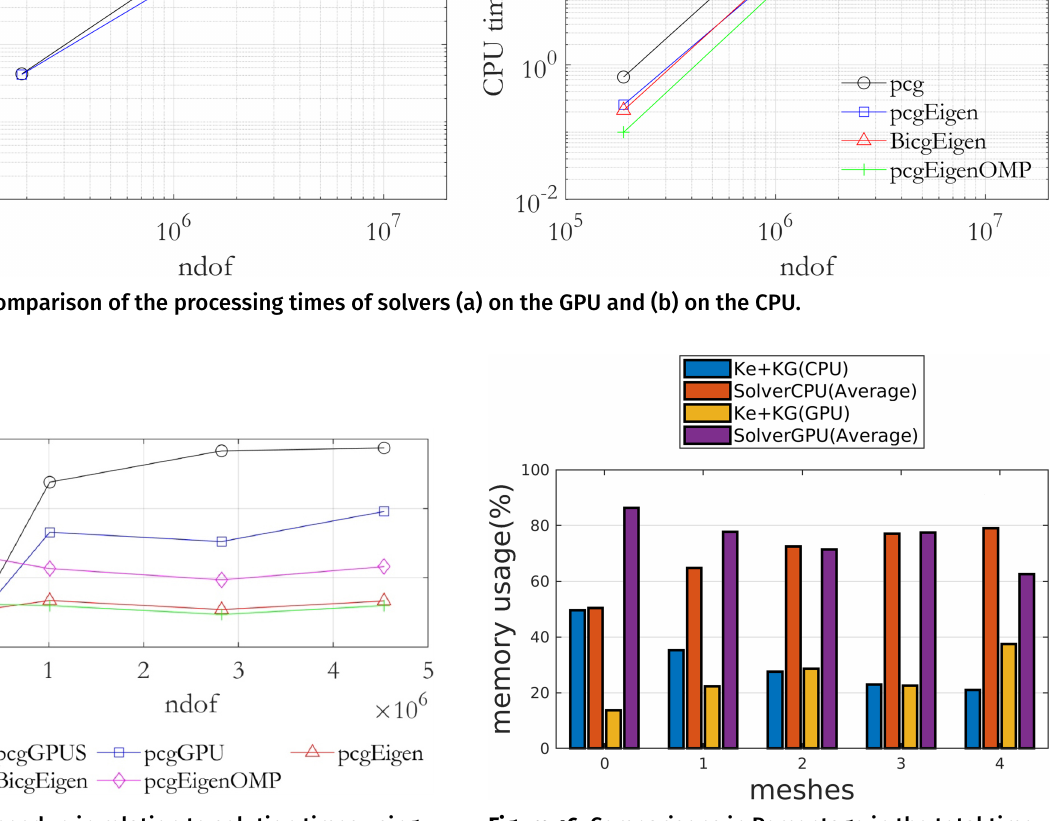
Figure 16. Comparisons in Percentage in the total time of the sum of the Ke and KG times against the solver in the CPU and in the GPU for each